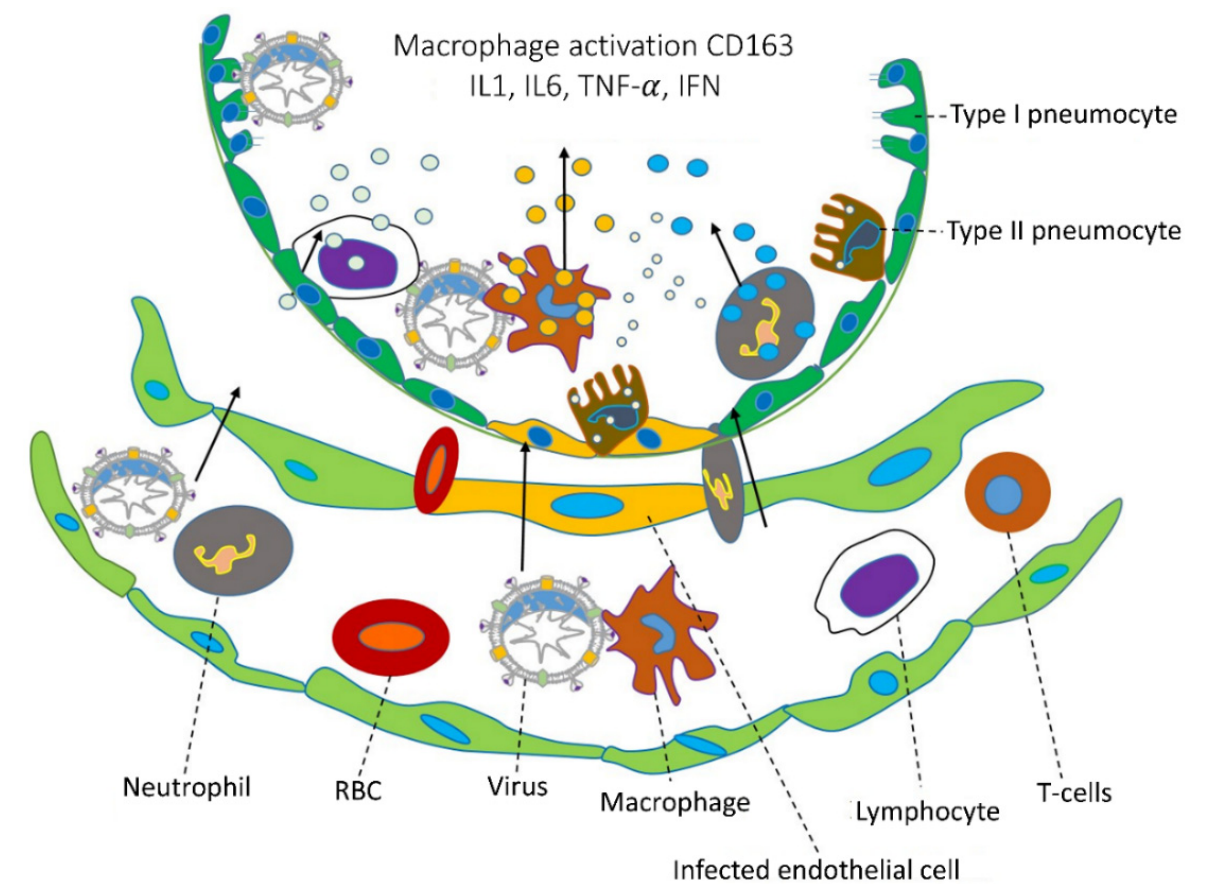
Figure 2. Coronavirus infections and immune approach. During coronavirus infections, the lower part of the lungs collects fluid in the bronchioles and disrupts surface coating types I and II pneumocytes. Additionally, they disrupt the immune response and increase cytokine release, which leads to the accumulation of reactive oxygen species. Various cytokines are secreted by CD163 macrophages activated by a viral infection in infected endothelial cells, and immune responses are caused by IL1, IL6, TNF- α , IFN, etc. Chemical catalysts by this cytokine attract various immune cells, such as neutrophils, lymphocytes, and T cells, through blood vessels. (The specific cells are indicated by dotted lines, and the direction of cell movement is indicated by an arrow).